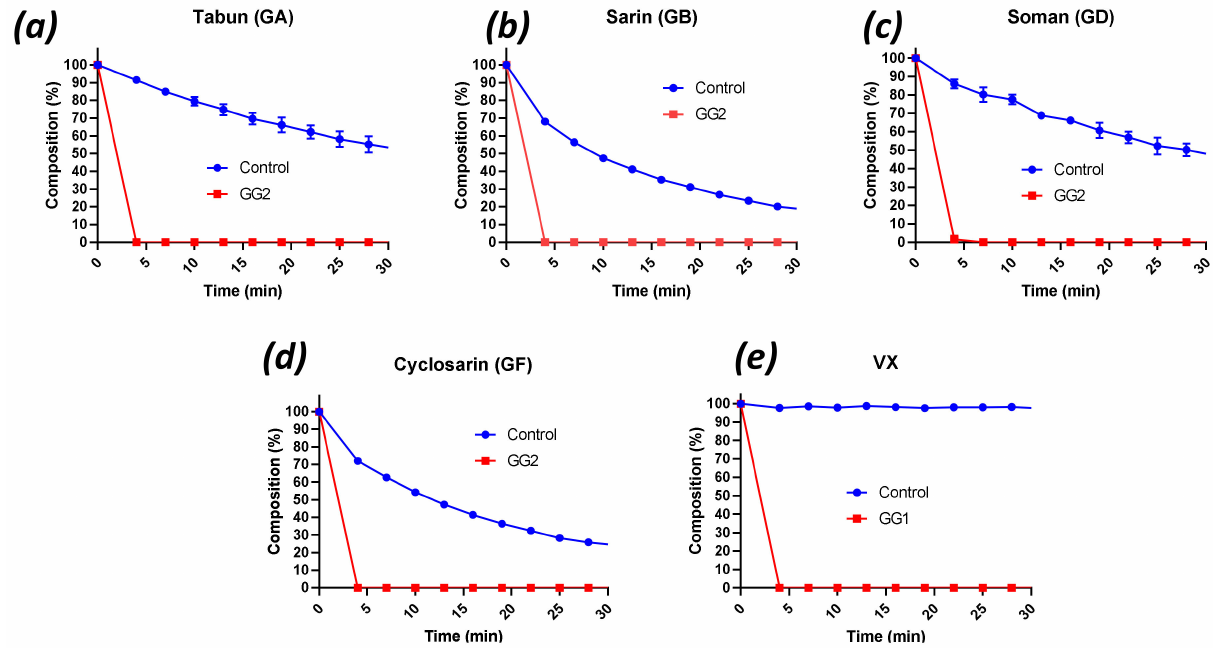
Figure 1. Degradation curves of ( a ) tabun GD, ( b ) sarin GB, ( c ) soman GD, and ( d ) cyclosarin GF by GG2, and of ( e ) VX hydrolysis by GG1. Agent concentration: 25 mM, enzyme concentration; 20 µ M. Experiments were conducted in 100–200 mM Tris buffer pH 9, 50 mM NaCl at 23 ◦